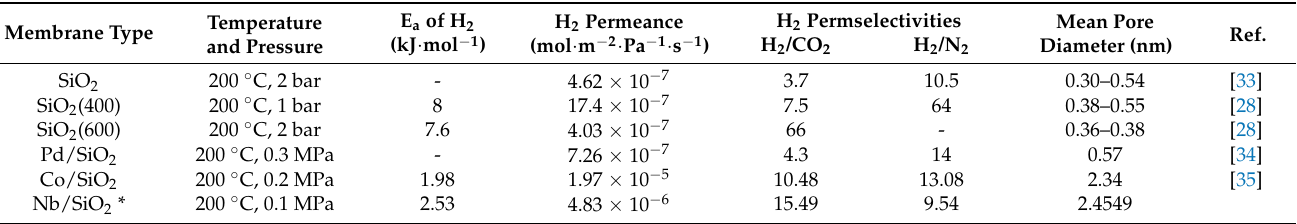
Table 4. E a of H 2 , H 2 permeances, H 2 permselectivities, and mean pore diameter for various SiO 2